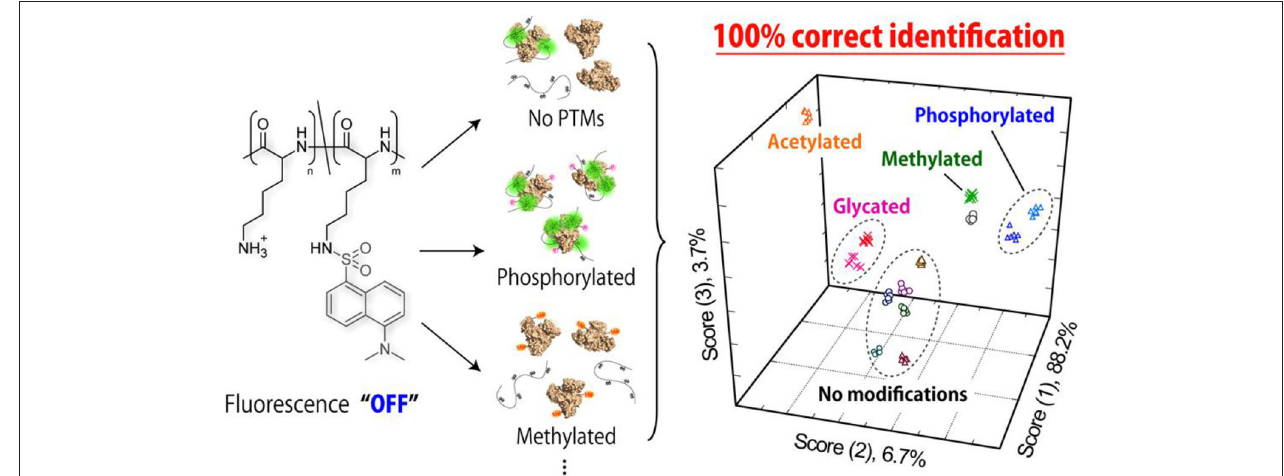
FIGURE 8 | Schematic illustration of fluorogenic interactions with proteins with/without PTMs. Reprinted from Tomita et al. (2017) with permission.